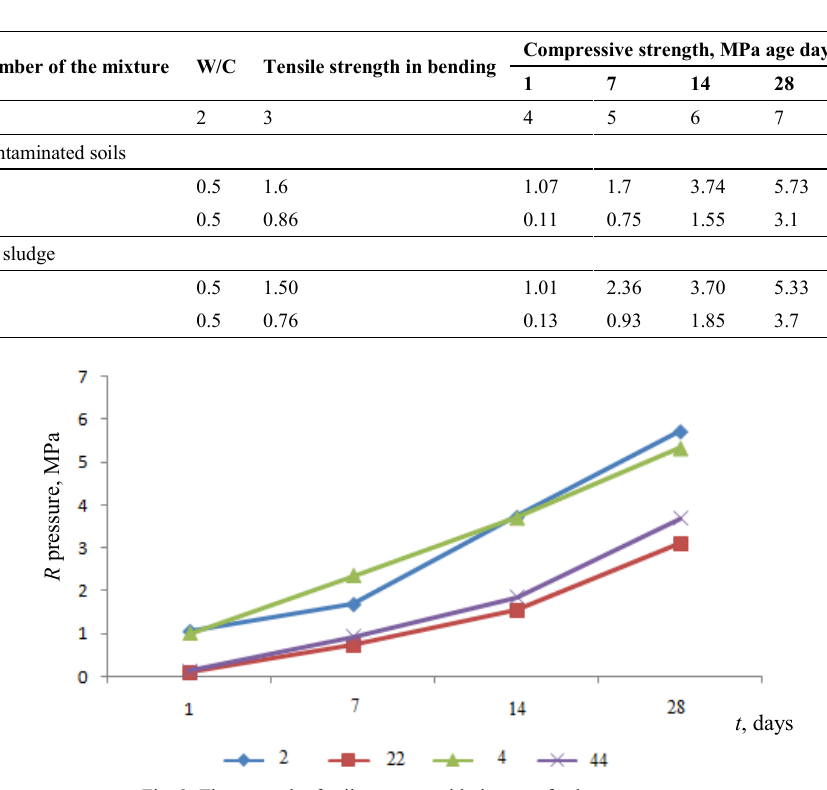
Fig. 2 . The strength of soil - concrete with the use of solar energy